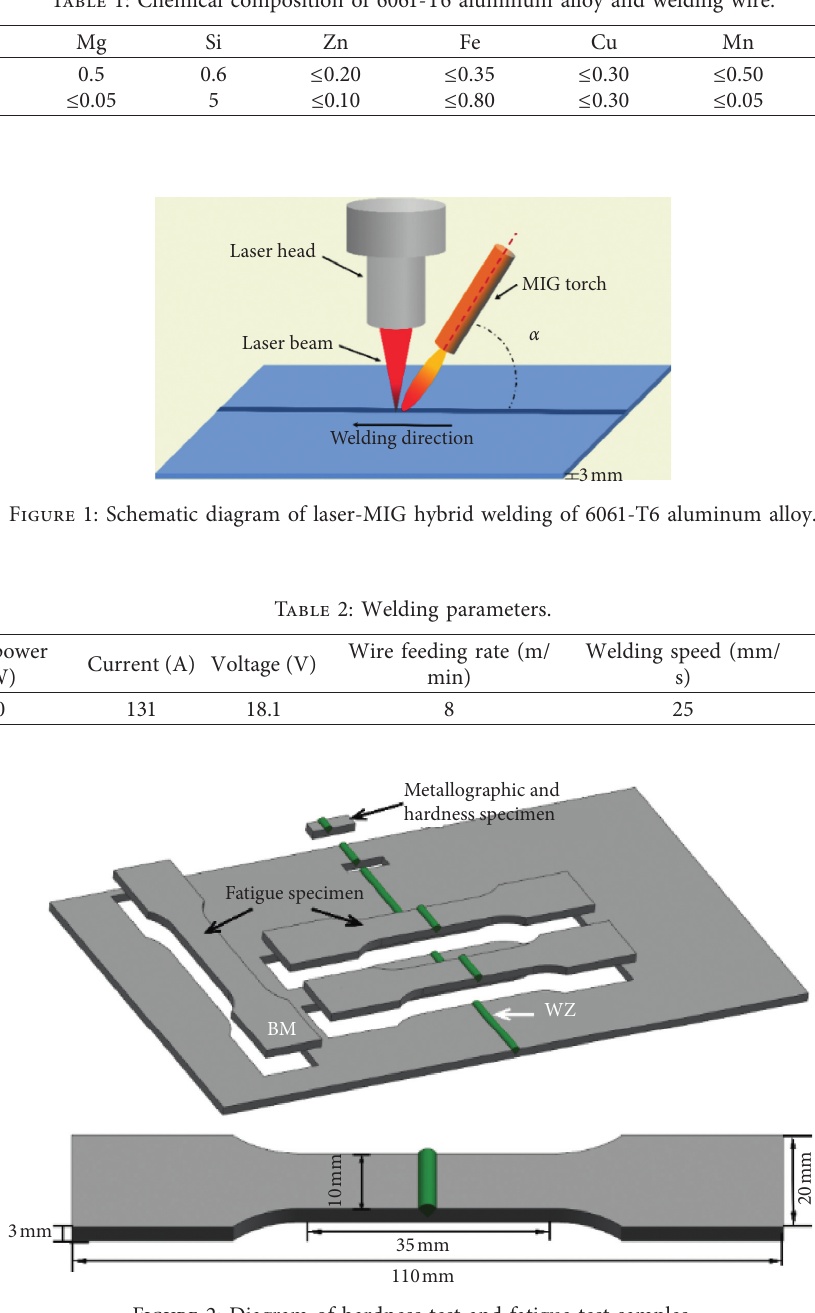
Figure 2: Diagram of hardness test and fatigue test samples.